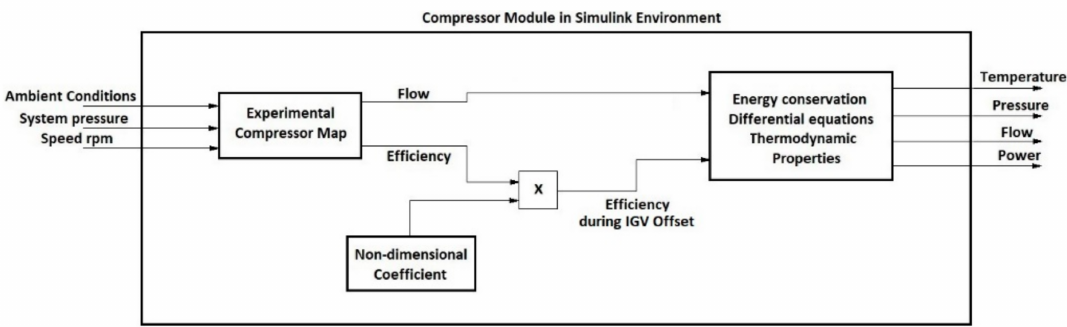
Figure 20. Implementation of non-dimensional coefficient in the compressor to simulate the effect of inlet guide vane (IGV) hysteresis on